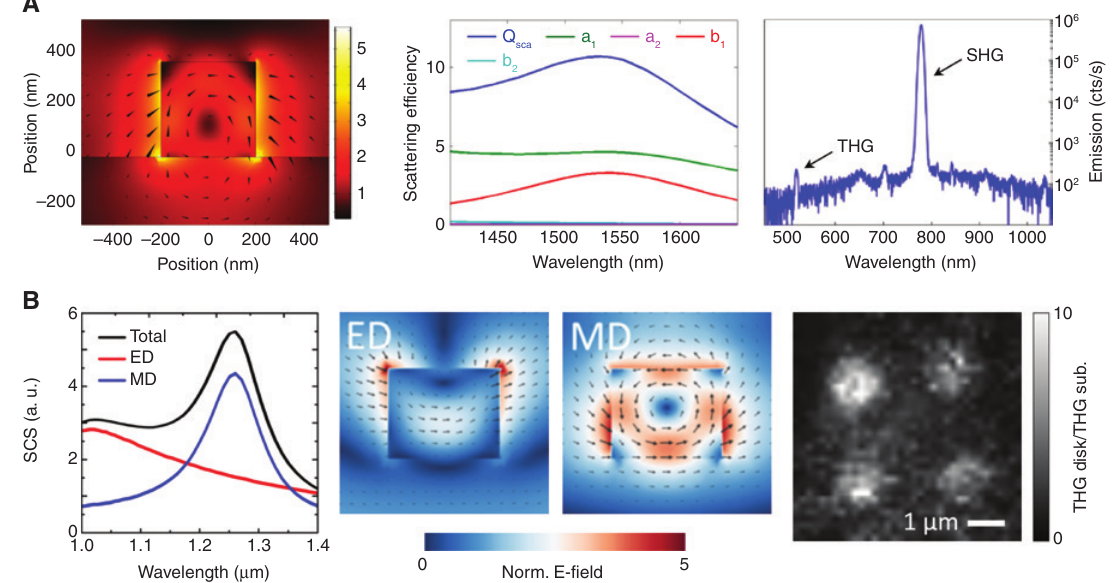
Figure 10: Non-linear light generation. (A) From left to right, electric field enhancement map in the cross-sectional plane of a monolithic aluminum gallium arsenide (AlGaAs) nanoantenna and its scattering efficiency (Q ), with the multiple expansion terms. The coefficients a , b , a and b are due to the electric sca 1 1 2 2 dipole, magnetic dipole, electric quadrupole and magnetic quadrupole contributions, respectively. SH emission spectrum of the optimized structure for the 500 μ W incident power Adapted with permission from Ref. [69], 2016 Optical Society of America. (B) From left to right, numerical scattering cross-section spectra of the nanodisks (black curve) decomposed in the electric dipole (red curve) and magnetic dipole (blue curve) contributions with corresponding electric field distribution maps in the cross-sectional plane. Scanning optical microscope image detecting the THG signal coming from the nanostructures and normalized to the signal acquired from the substrate area. Adapted with permission from Shcherbakov MR, Neshev DN, Hopkins B, et al. Enhanced third-harmonic generation in silicon nanoparticles driven